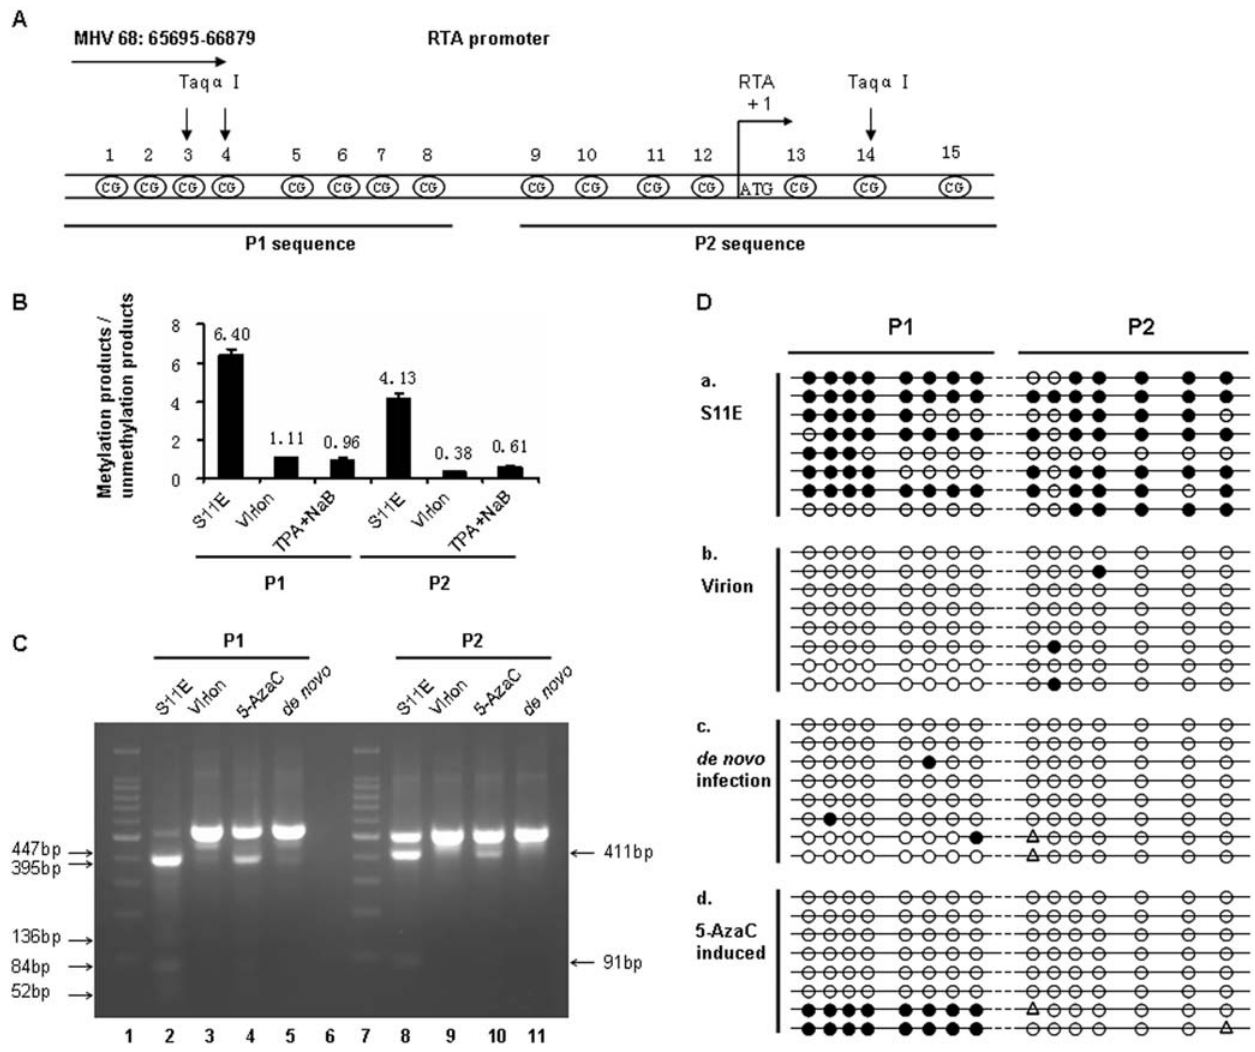
Figure 2. Methylation status at the MHV-68 RTA promoter. (A) A schematic view of the RTA promoter on MHV-68 genome (NC_001826, n.t. 65695-66879). The 15 CpG sites shown were analyzed in this study, the promoter region divided into two parts for analysis, named P1 and P2. (B) Quantitative methylation-specific PCR (Q-MSP) analysis of the RTA promoter methylation status. Genomic DNAs were prepared from untreated S11E cells, MHV-68 virion or TPA (25 ng/ml) plus NaB (4 mM) treated S11E cells. Then Q-MSP was performed to detect methylation status of the RTA promoter P1 and P2 fragments, using methylation-specific (M) or unmethylation-specific (U) primers, respectively. Standard reactions were performed at the same time to quantify copy numbers, and the ratio of methylation-specific and unmethylation-specific products was calculated for each sample. Results represent the average from three experiments, with standard deviations shown. (C) Combined bisulfite restriction analysis (COBRA) of the MHV-68 RTA promoter methylation status. Genomic DNAs were prepared from untreated S11E cells, MHV-68 virion, 5-AzaC (10 m M, 36 hrs) induced S11E cells or de novo infected MHV-68 BHK-21 cells, bisulfite modified, and subsequently used for PCR amplification. The PCR products were digested by Taq a | for COBRA. The digested products for P1 fragments are 84 bp, 52 bp, 136 bp, 447 bp and 395 bp. The digested products for P2 fragments are 411 bp and 91 bp. (D) Bisulfite genomic sequencing (BGS) analysis of the 15 CpG sites at the RTA promoter. Genomic DNAs from untreated S11E cells, MHV-68 virion, de novo infected MHV-68 BHK-21 cells or 5-AzaC (10 m M, 24 hrs) induced S11E cells, bisulfite modified, and then used for PCR amplification, The PCR products were cloned into T-A vector. Each group included eight independent clones. Solid circles indicate methylated CpG, open circles indicate unmethylated CpG and triangle indicate ambiguous sequencing